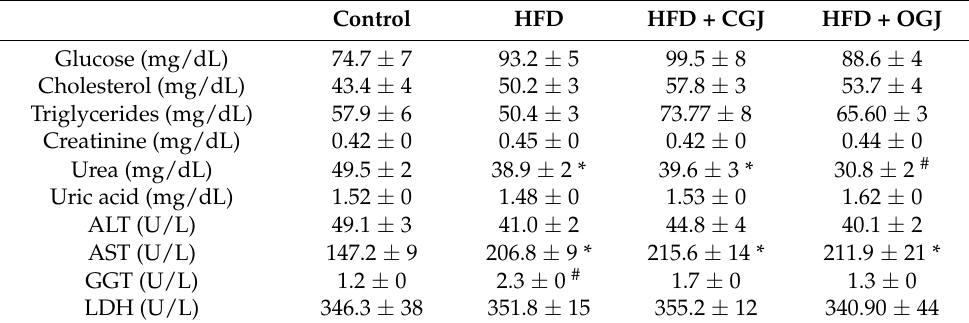
Table 4. Evaluation of biochemical parameters after 12 weeks of treatment with high-fat diet (HFD), conventional grape juice (CGJ), and/or organic grape juice (OGJ).